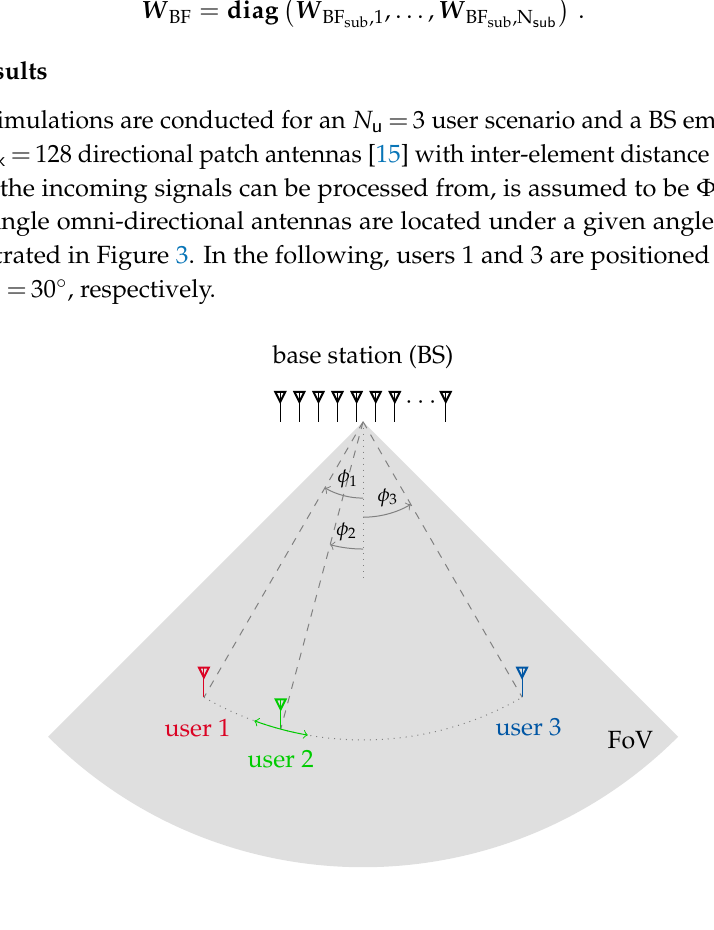
Figure 3. User and base station (BS) arrangement to evaluate the noncoherent massive MIMO system with digital beamspace